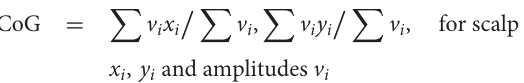
Frontiers in Human Neuroscience |